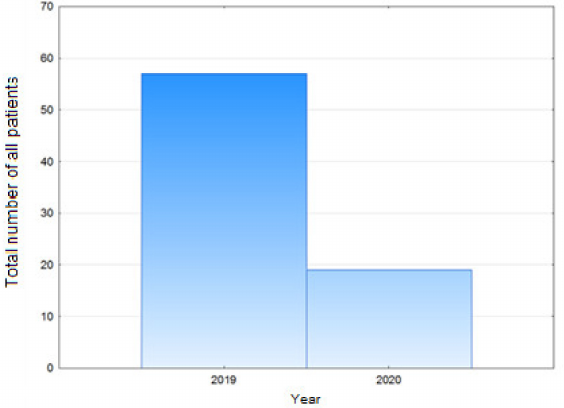
Figure 2. Total number of all patients—knee